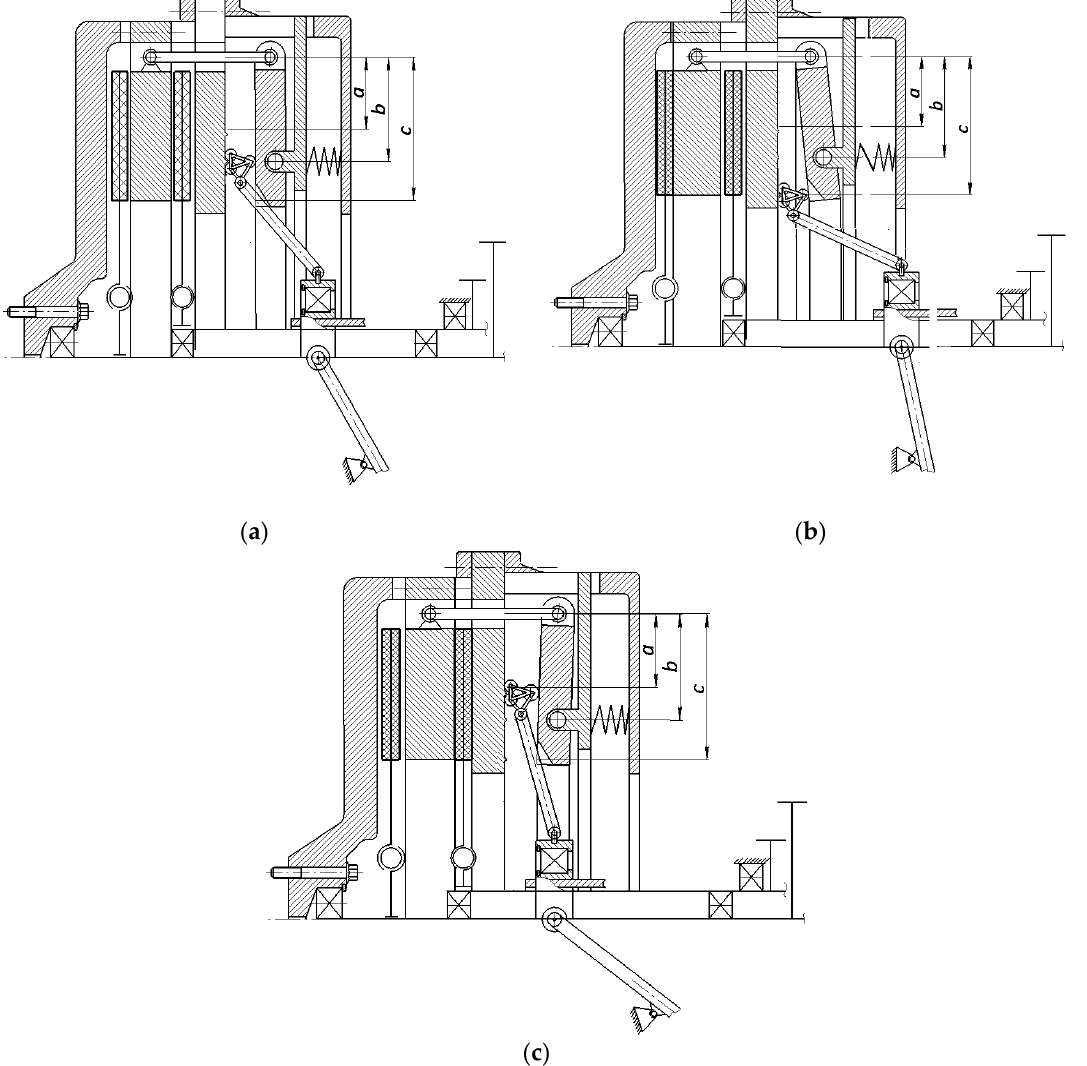
Figure 3. Positions of the movable carriage of the control mechanism: ( a )—neutral position; ( b )—1st clutch; ( c )—2nd clutch; a – length determining the position of the carriage under switched-on 2nd clutch, b – length determining the position of the carriage under switched-off 1st and 2nd clutches, c – length determining the position of the carriage under switched-on 1st clutch.